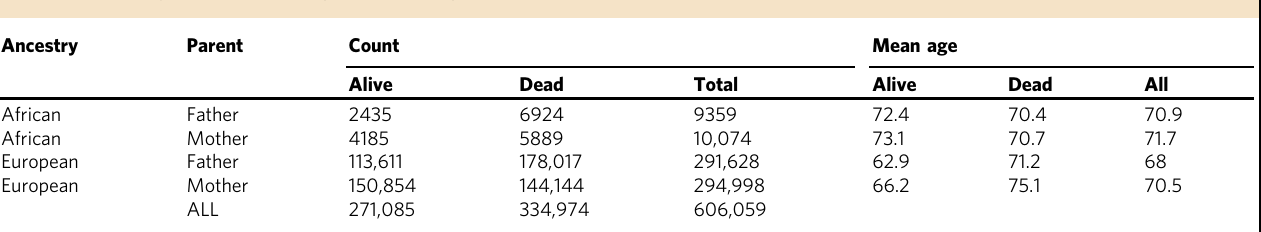
Table 1 Summary of the LifeGen parental